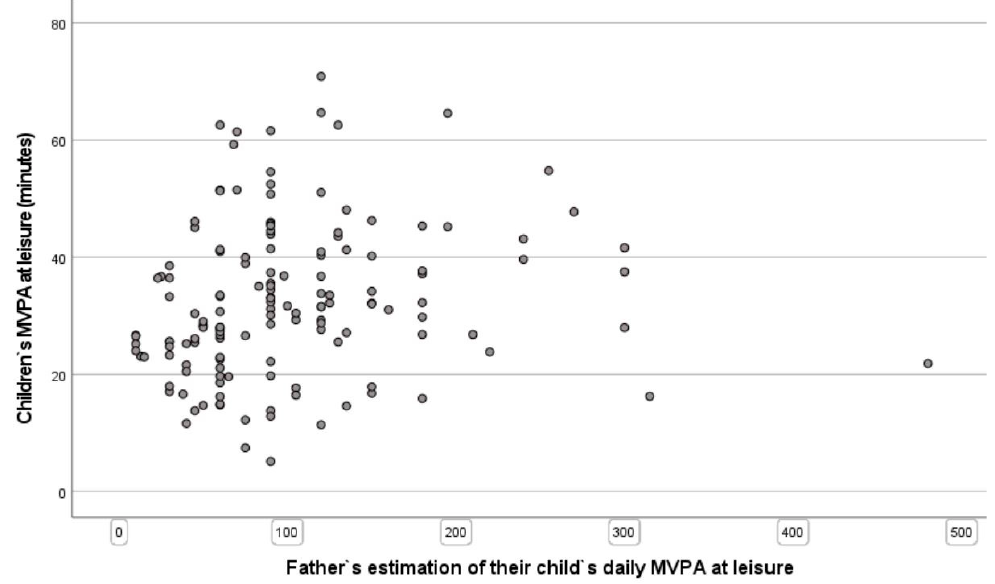
Figure 2. Scatter plot of preschool children’s MVPA at leisure time and fathers’ estimation of their children’s PA level. Table 4. Pearson correlations between preschool children’s MVPA and parents’ reported participation in MVPA with their children.